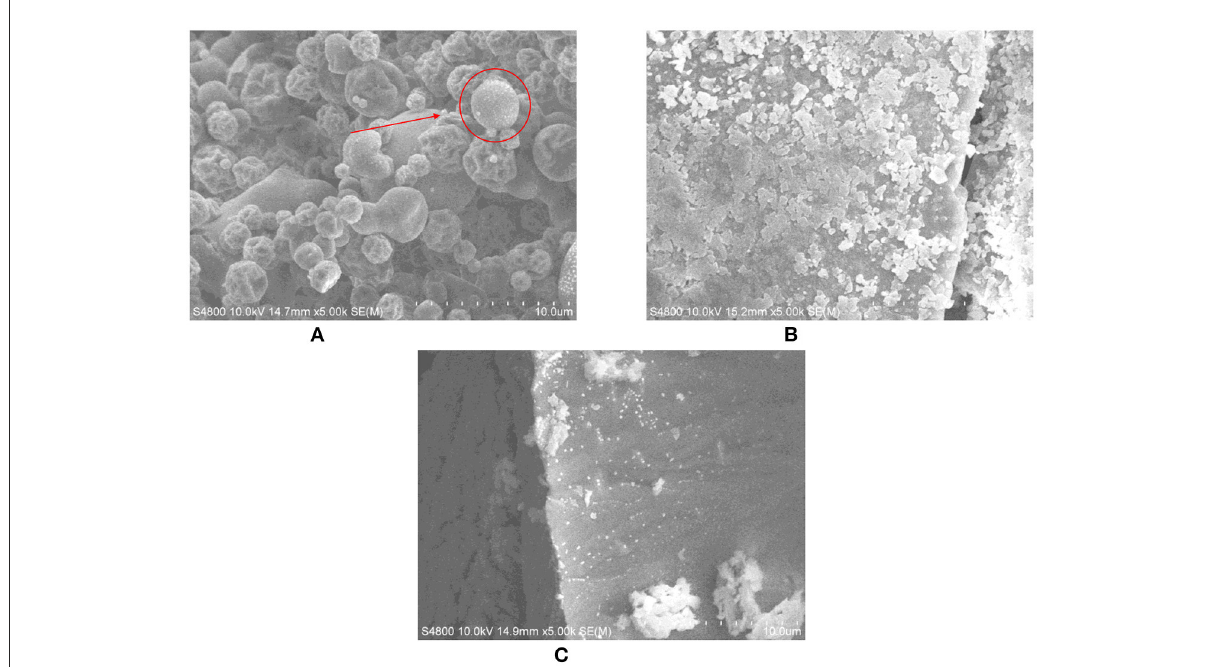
FIGURE5 Microstructure of protein peptide powder by three drying methods. (A) Freeze drying. (B) Spray drying. (C) Vacuum drying.